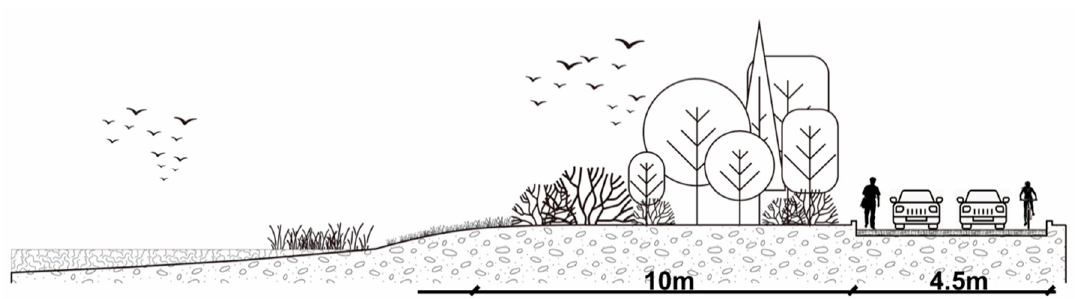
Figure 3. Illustration of the river section. Local environmental variables were investigated from field surveys in 54 sample sites (size: 10 × 10 m).